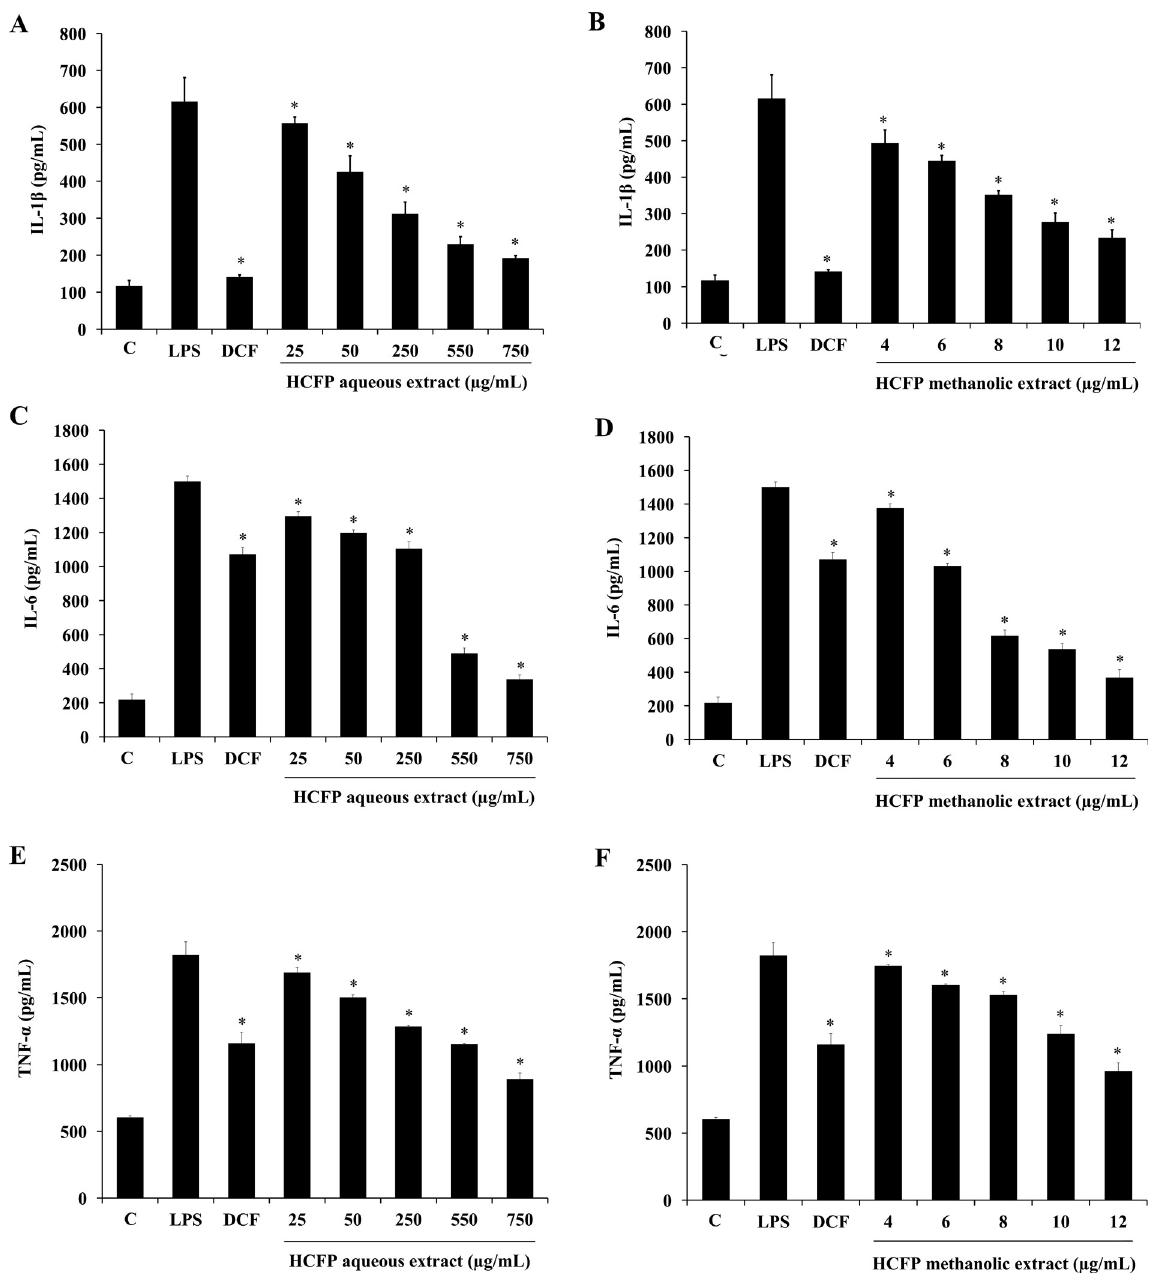
Fig 4. Effect of HCFP on production of IL-1 β (A, B), IL-6 (C, D) and TNF- α (E, F) in LPS-stimulated RAW264.7 cells. The cells were pre- treated with the indicated concentration of aqueous extract or phenolic extract for 2 h then stimulated with LPS (1 μ g/mL) for 24 h. The IL-1 β , IL-6, and TNF- α in cultured medium were determined by ELISA kits. Data were expressed as the mean ± S.D. of two independent experiments. Statistically significant inhibitions of IL-1 β , IL-6 and TNF- α production ( � p < 0.05) were found as compared with the LPS group. concentration of HCFP aqueous (750 μ g/mL) (Fig 4A) or methanolic (12 μ g/mL) (Fig 4B) extract, respectively. LPS-induced IL-6 production was inhibited by 77.38 or 75.53% when treated with the highest concentration of HCFP aqueous (Fig 4C) or methanolic (Fig 4D) extract, respectively. In addition, LPS-induced TNF- α production was inhibited by 50.99 or